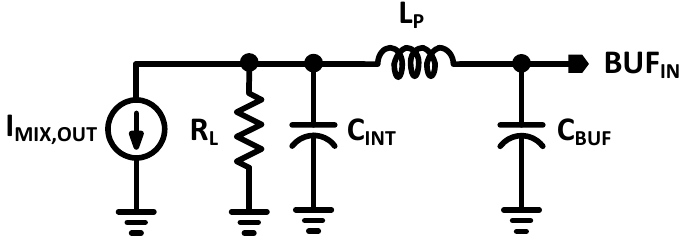
Figure 8. Modeling of the mixer load with additional inductor for bandwidth extension.